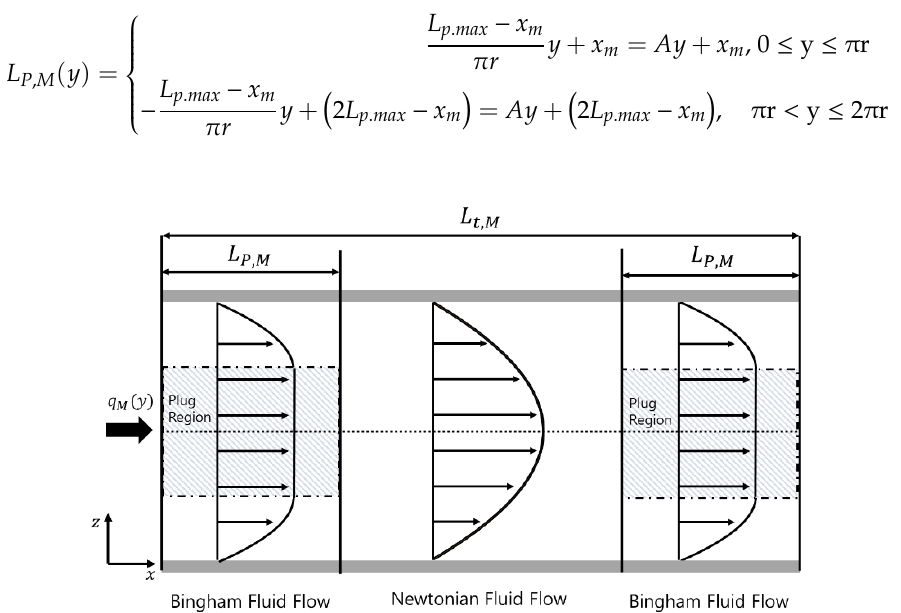
Figure 10. Mean velocity profile of MR fluid in the main orifice.